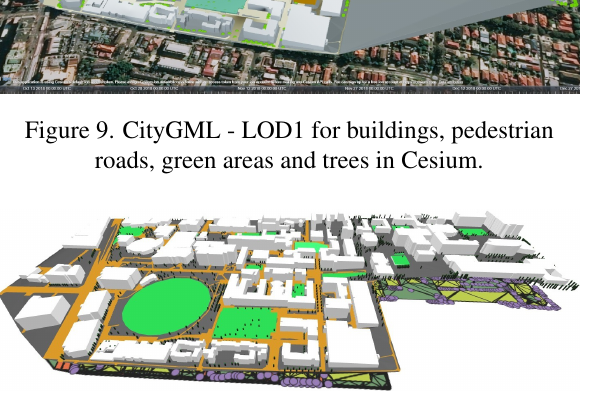
Figure 10. CityGML - LOD1 for buildings, pedestrian roads, green areas and trees in QGIS.